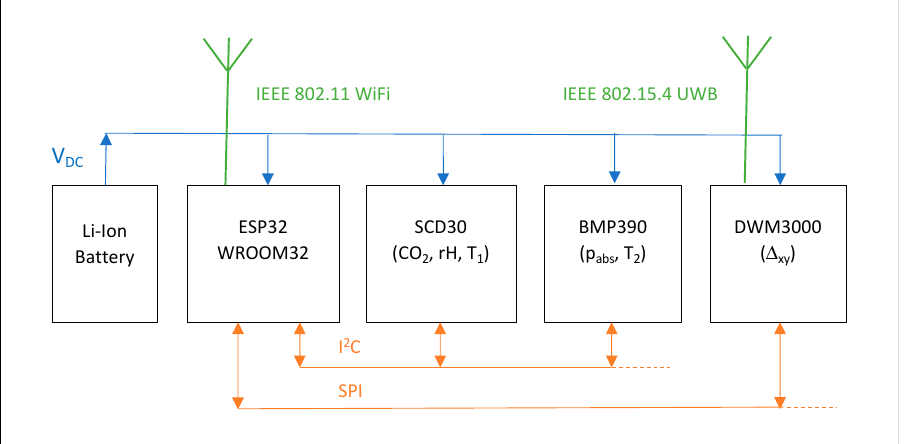
Figure 2. Block diagram of the node hardware.